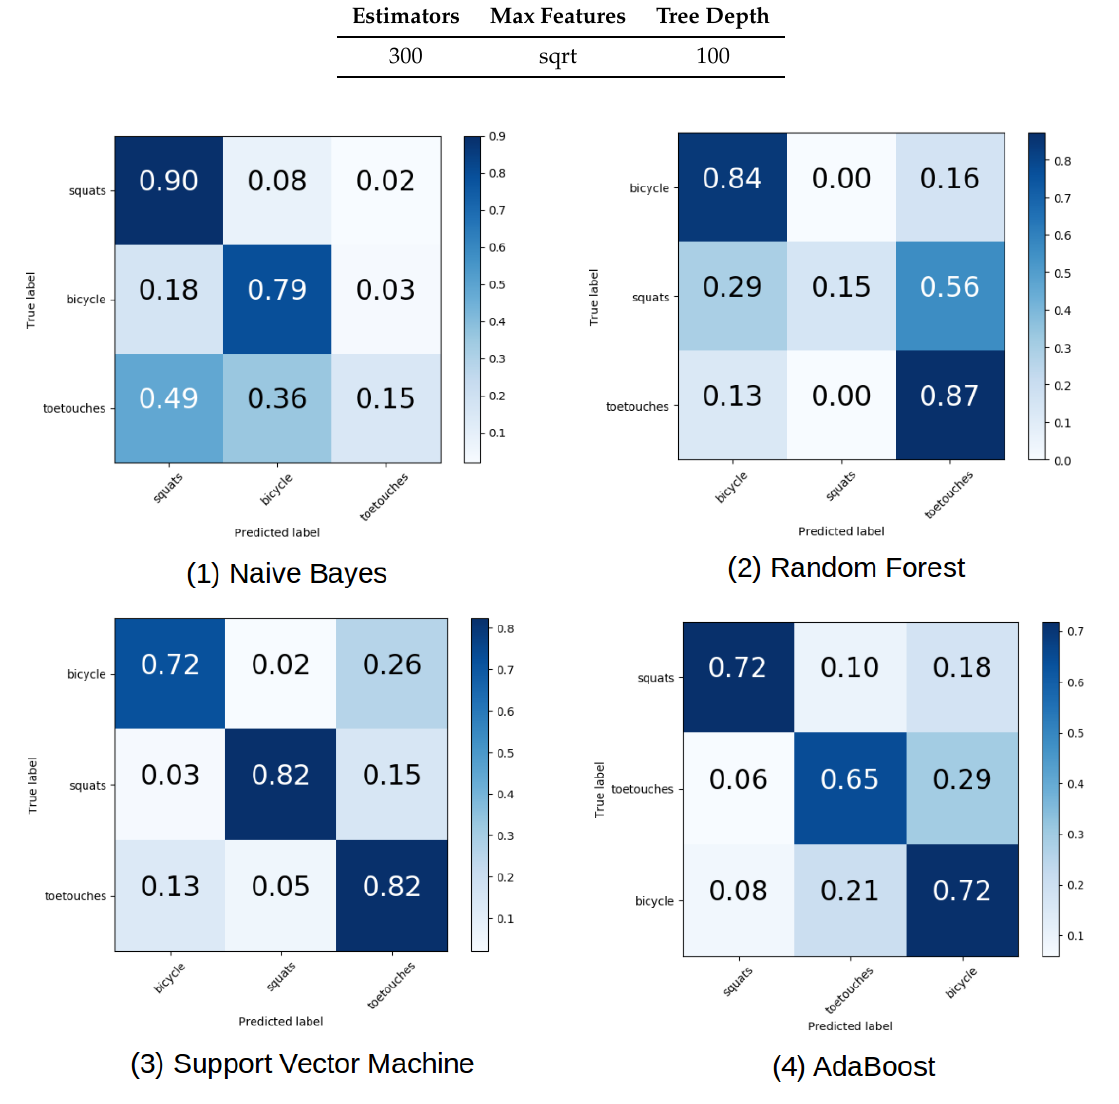
Figure 3. The confusion matrix for different classifiers are depicted. Top left ( 1 ) shows the confusion matrix for the Naive Bayes Classifier. Top right ( 2 ) shows the confusion matrix for the Random Forest classifier. Bottom left ( 3 ) shows the confusion matrix for the Support Vector Machine classifier. Bottom right ( 4 ) shows the confusion matrix for the AdaBoost classifier. As can be clearly seen from the results, AdaBoost classifier performs better than Naive Bayes and Random Forest. Although with higher computational load, it has a worse accuracy than support vector machine. The support vector machine shows the best recognition results with fewer misclassification